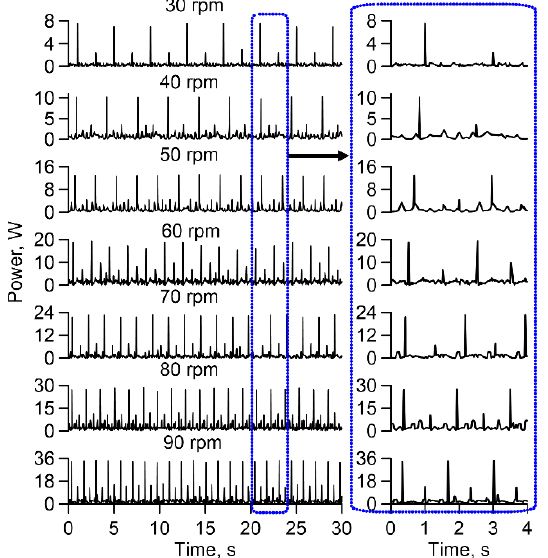
Table 8. Results of power consumption according to speed condition